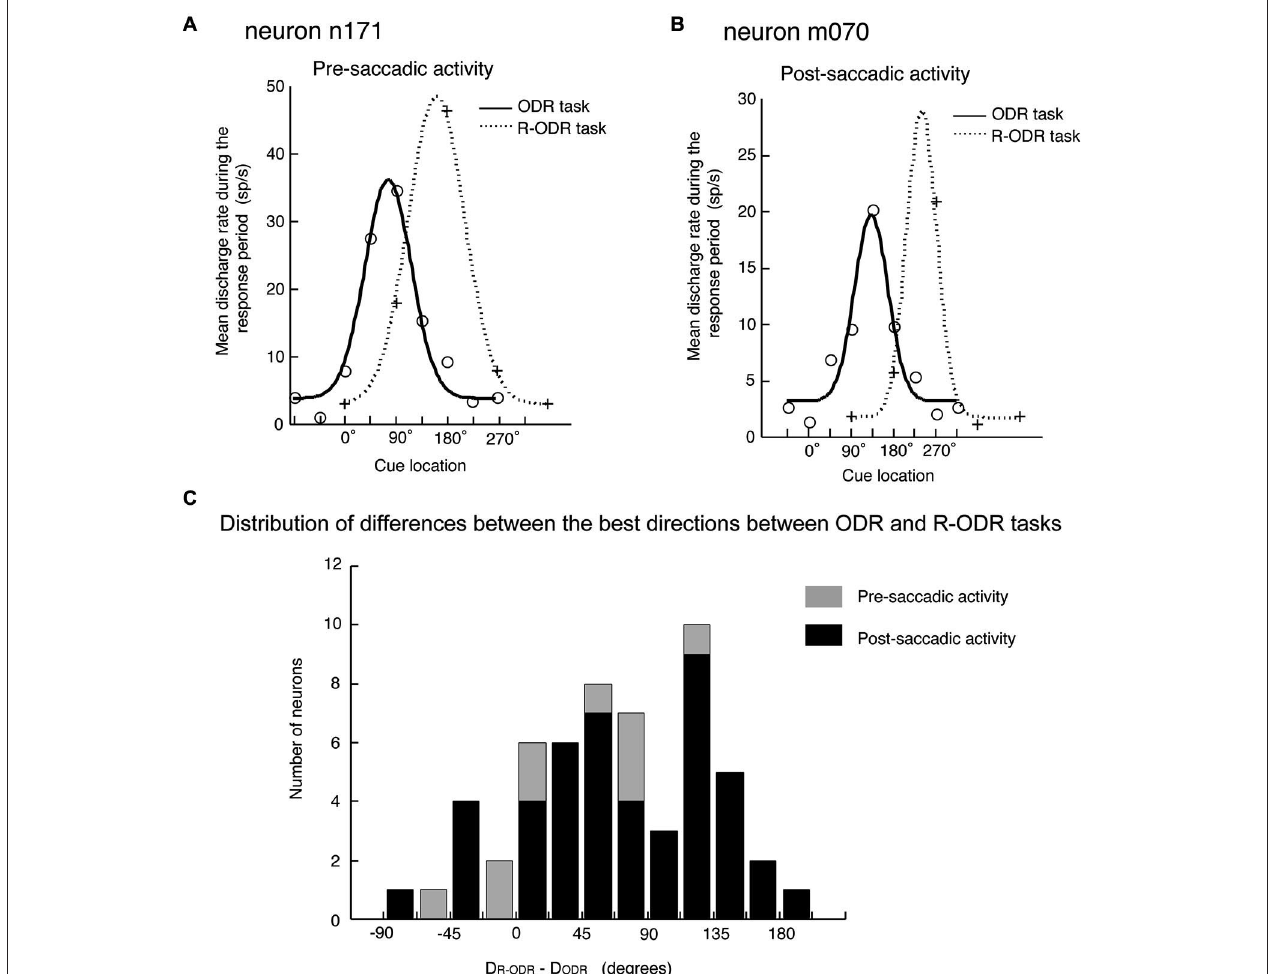
R-ODR task. Therefore, if the best direction of saccade-related activity was the same in these two tasks, we could conclude that this activity encoded the direction of the visual cue. On the other hand, if the best direction of saccade-related activity in the R-ODR task was 90 o clockwise from the best direction in the ODR task, we could conclude that this activity encoded the direction of the saccade. Adapted from Funahashi and Takeda